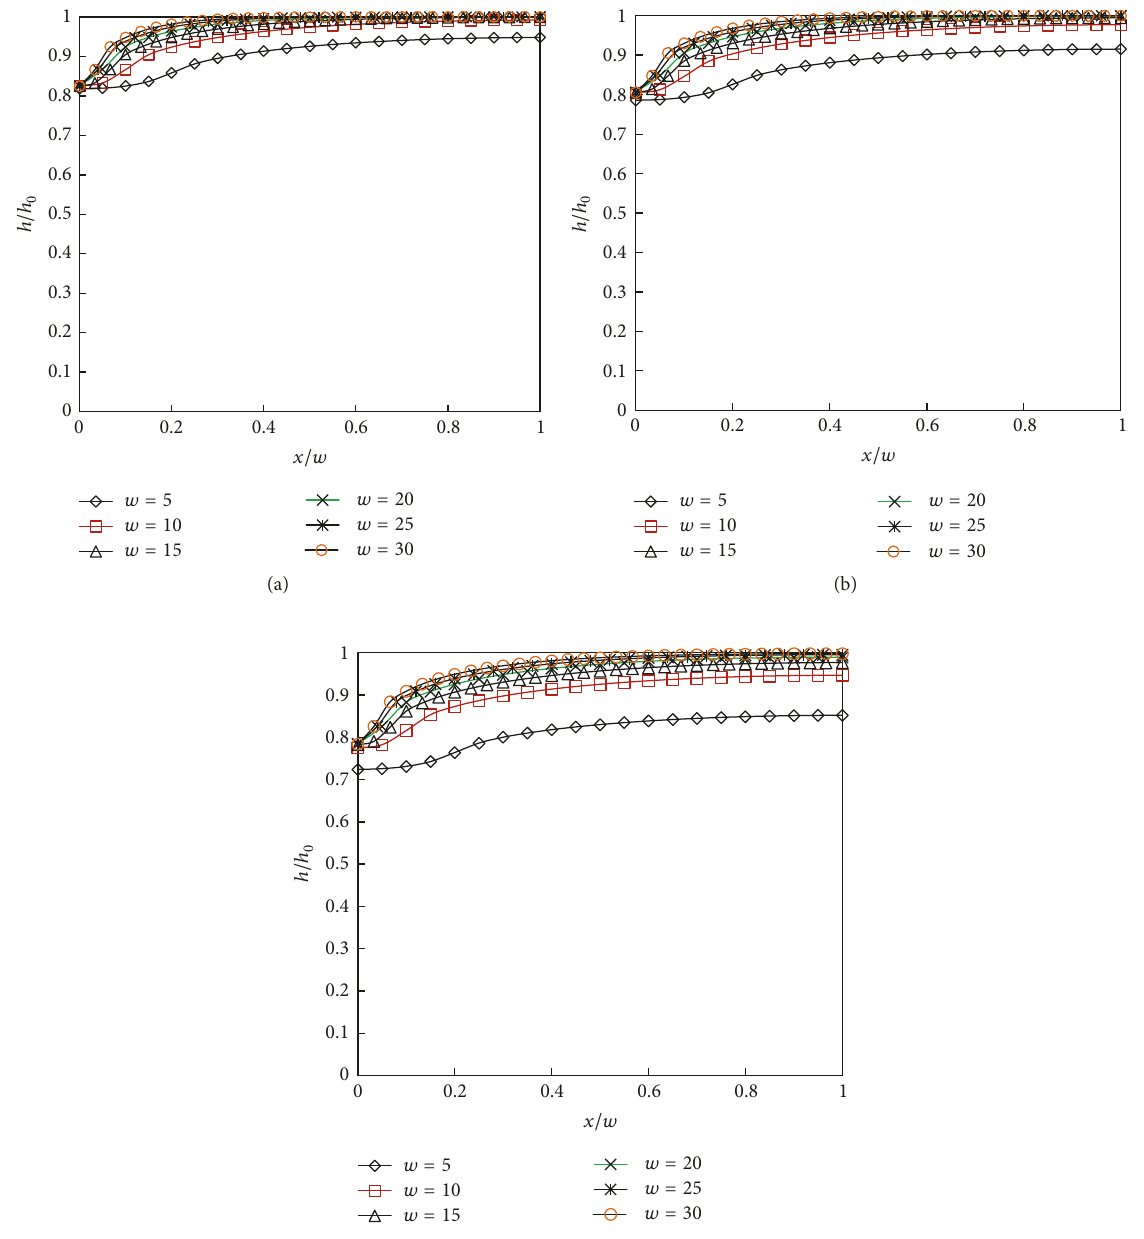
Figure 7: The effect of infiltration width on the pore-water pressure head at the boundary 0B: (a) 𝑡 = 5 h; (b) 𝑡 = 10h; (c) 𝑡 = 50 h.